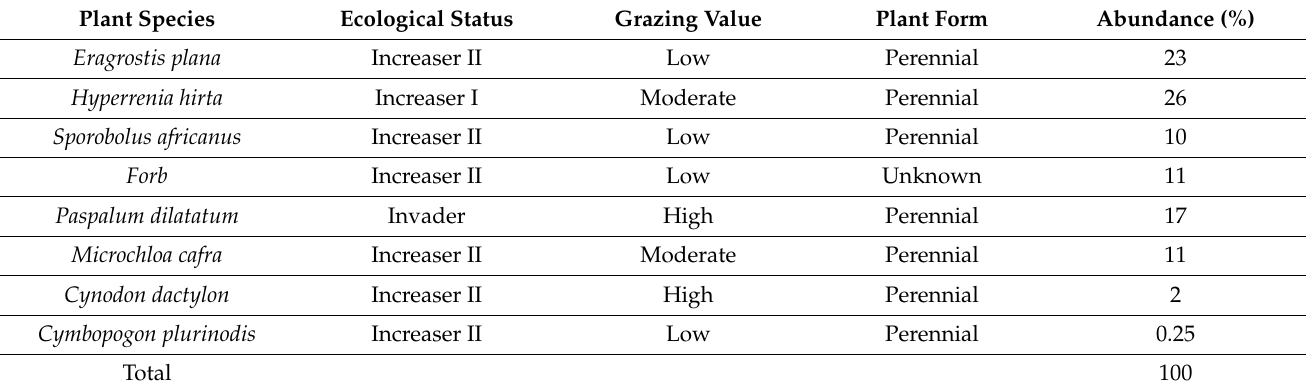
Table 2. Overall mean percentage abundances of species composition in the village of